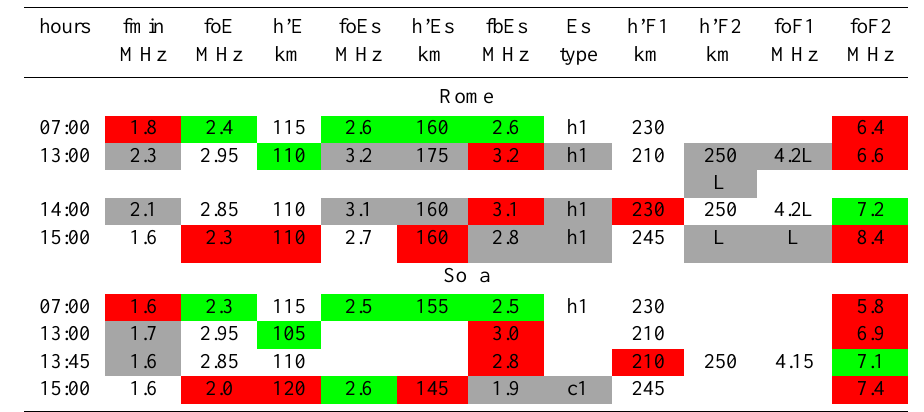
Table 2. Ionospheric parameters on 14 October 1997 at 07:00, 13:00, 13:45 ∗ , and